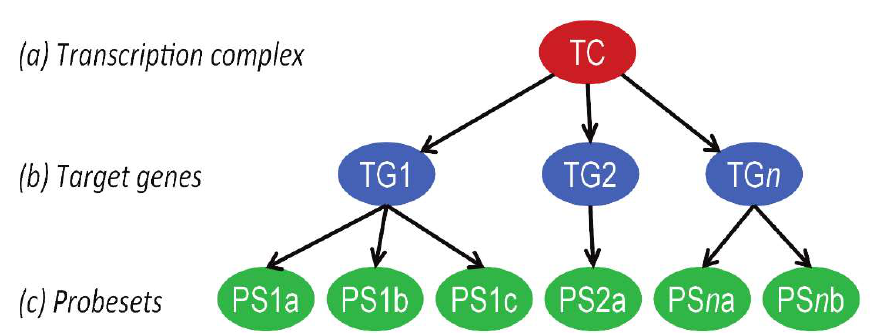
Figure 4. Bayesian model for the Notch signal transduction pathway. The structure of the Bayesian network used to model the transcriptional program of signaling pathways. The transcription complex refers to the transcription factor associated with a specific signal transduction pathway, which can be present in an inactive or active gene transcribing state; target genes refers to direct target genes of the transcription complex; probesets refers to probesets for the respective target gene present on Affymetrix HG-U133 Plus 2.0 microarray. With permission, [24 ] .